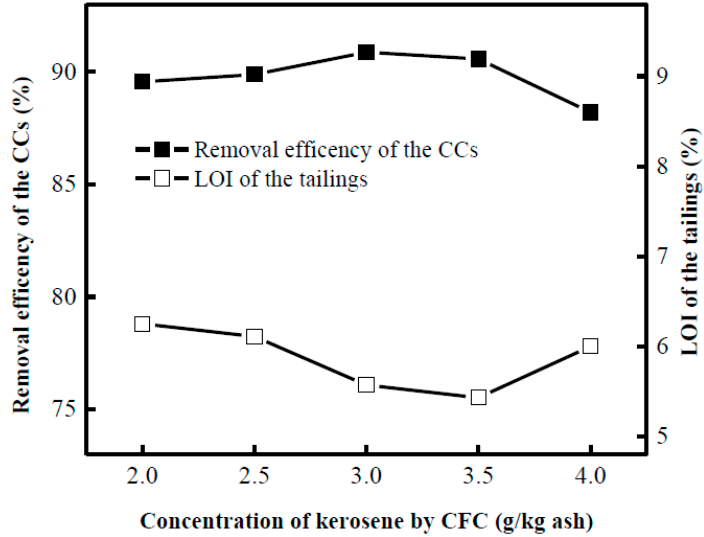
Figure 3. Effect of kerosene concentration on decarburization by conventional flotation cell (CFC): MIBC = 0.1 g/kg · ash, Tween 80 = 5% of the kerosene dosage, slurry concentration = 100 g/L, and impeller speed = 2000 r/min.